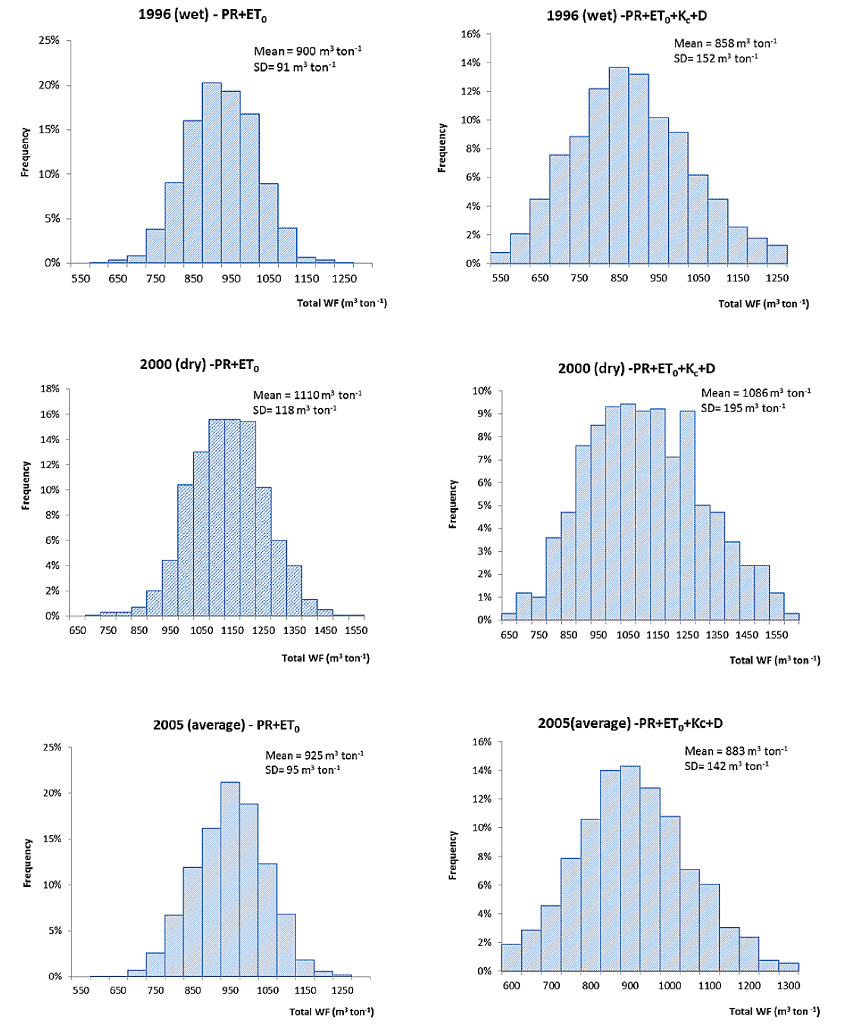
Figure 9. Probability distribution of the total WF of maize given the combined uncertainties in PR and ET 0 (graphs at the left) and given the combined uncertainties in PR, ET 0 , K c and D (graphs at the right), for the years 1996, 2000 and 2005.